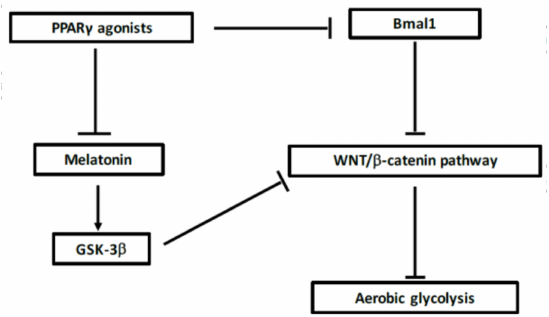
Figure 4. Schematic interaction between WNT, peroxisome proliferator-activated receptor γ (PPAR γ ) and circadian rhythms. PPAR γ agonists can decrease Bmal1 expression. The knockout of Bmal1 leads to decrease WNT/ β -catenin pathway activity and then in absence of initiation of aerobic glycolysis. In parallel, PPAR γ agonists can decrease melatonin levels leading to activate GSK-3 β activity, the main inhibitor of WNT